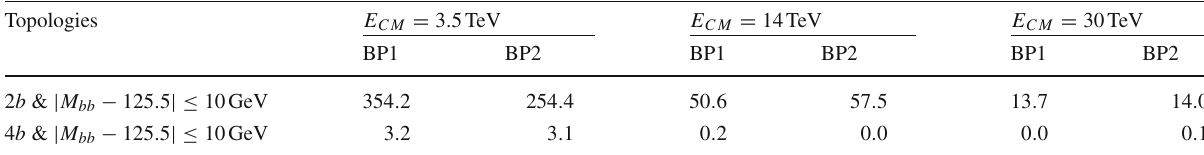
Fig. 26 a Di-bjet-mono-lepton ( M bb (cid:5) ) invariant mass distribution with Y N = 5 × 10 − 7 , b di-jet-mono-lepton ( M jj (cid:5) ) invariant mass distributions with Y N = 1 × 10 − 8 for the benchmark points at the muon collider with the centre of mass energy 3.5 TeV